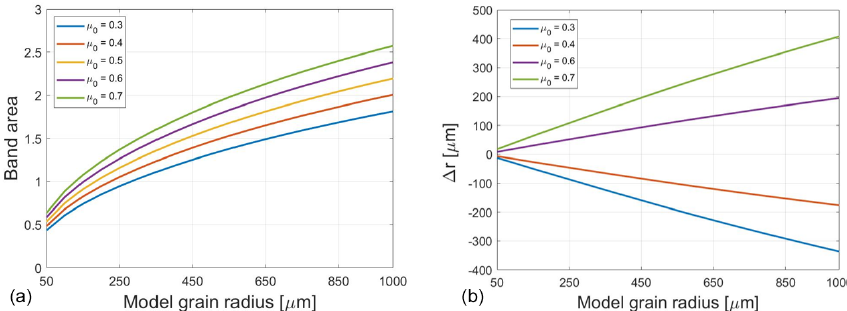
Figure 4. Band area as a function of grain size and solar zenith angle (a) and the corresponding grain size biases (b) . The term “ µ 0 ” refers to the cosine of the solar zenith angle. Biases are computed relative to the baseline calibration function assuming θ 0 = 60 ◦ ( µ 0 = 0 . 5).